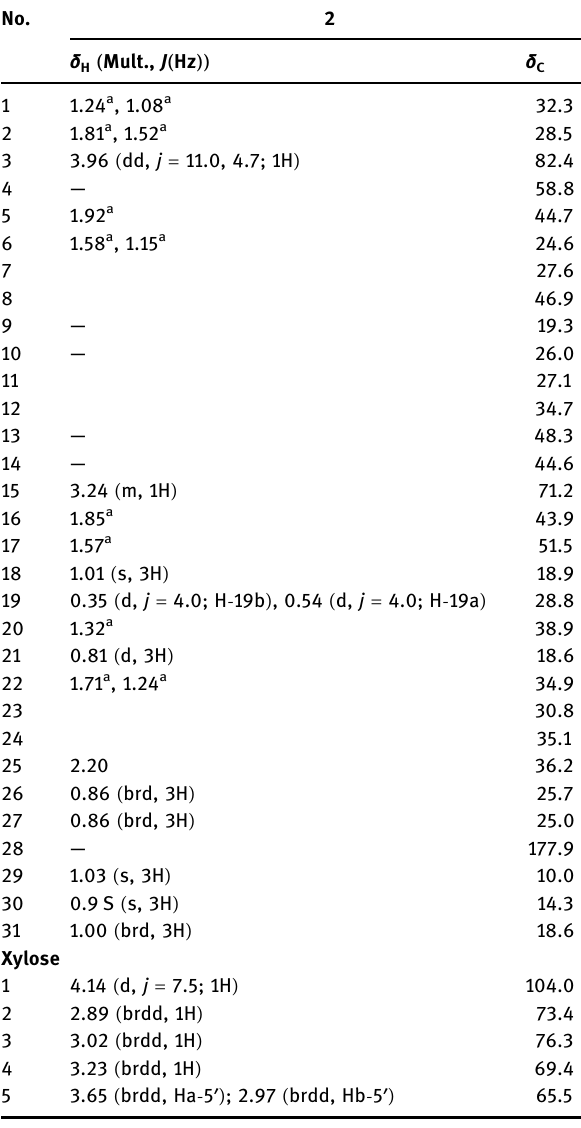
Table 1: 1 H and 13 C NMR data for compounds 1 ( CDCl 3, δ in ppm, 600 and 151 MHz )